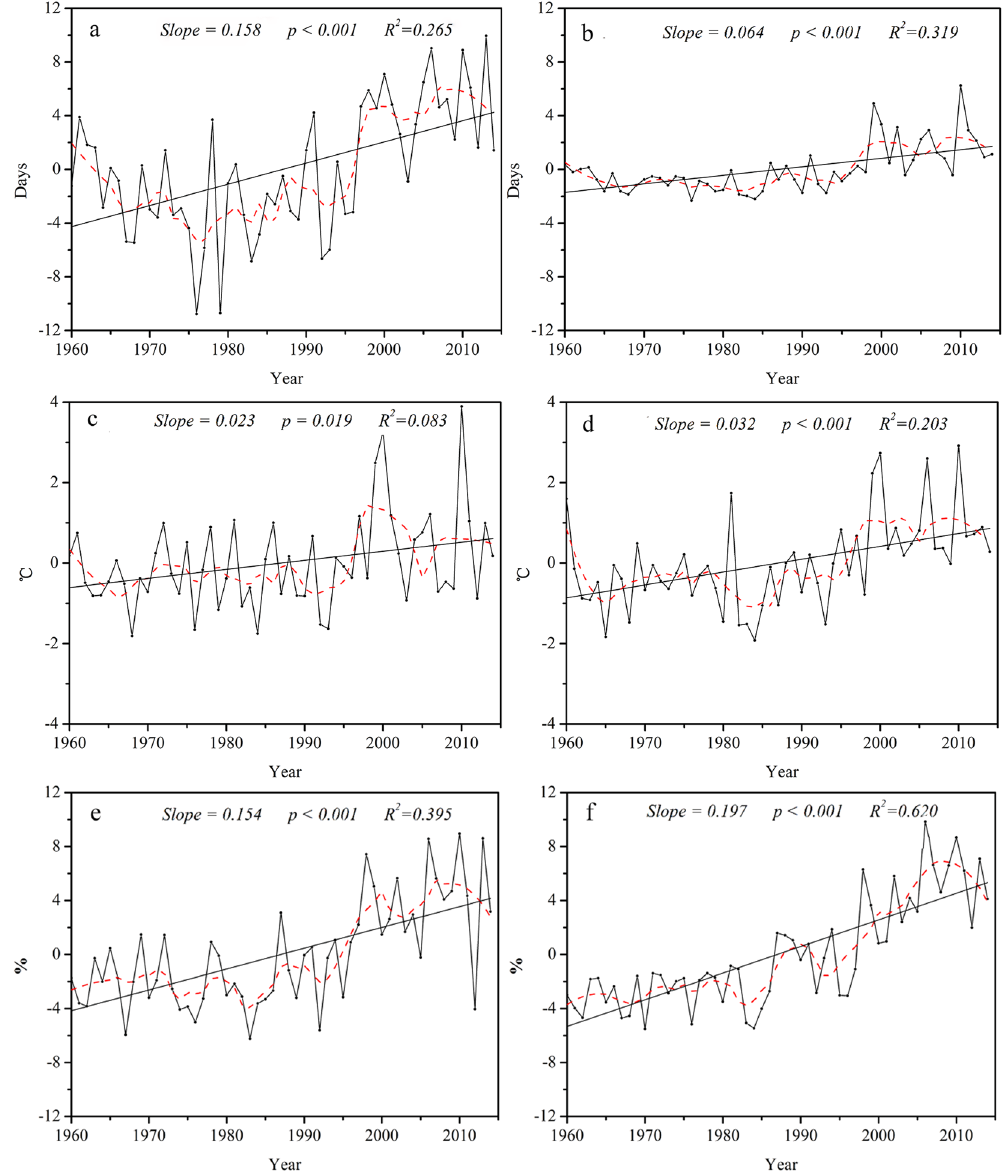
Figure 4. Annual regional averaged series for warm extremes. Warm indices: summer days ( a ), tropical nights ( b ), warmest days ( c ), warmest night ( d ), warm days ( e ), warm nights ( f ). For description of indices, see Supplementary Table S1. Straight line represents the linear regression and the dash line is the 10-year smoothed